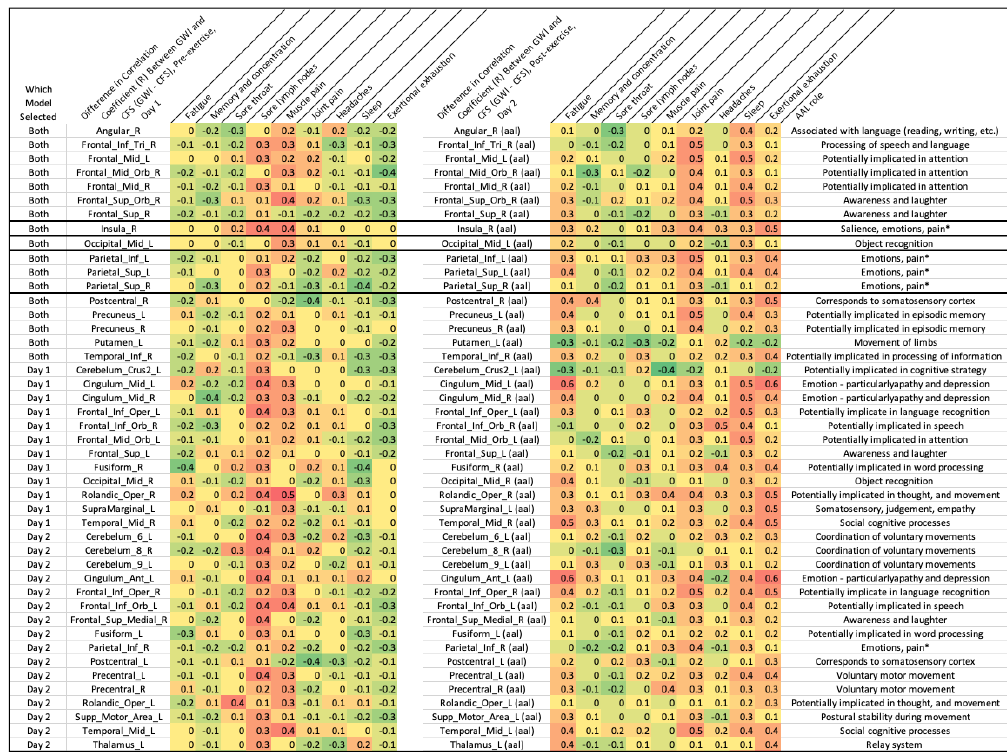
Figure 6. Differences between GWI and CFS in Pearson’s correlation coefficients (symptom severity score vs. AAL region) were compared on both days. These differences were also compared to prior known functional associations to AAL regions. Most notably, regions implicated in the “pain cortex” (parietal cortex and insula) had larger differences in correlation coefficients between GWI and CFS [23–25]. Many of the remaining regions selected by the model play a role in attention and memory even if the individual difference in correlation was not strong. This is likely explained by the use of these regions for the n-back working memory task.